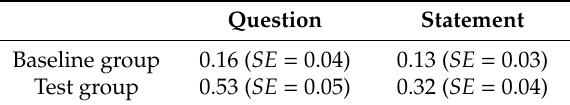
Table 5. Proportion overt C2 preference.